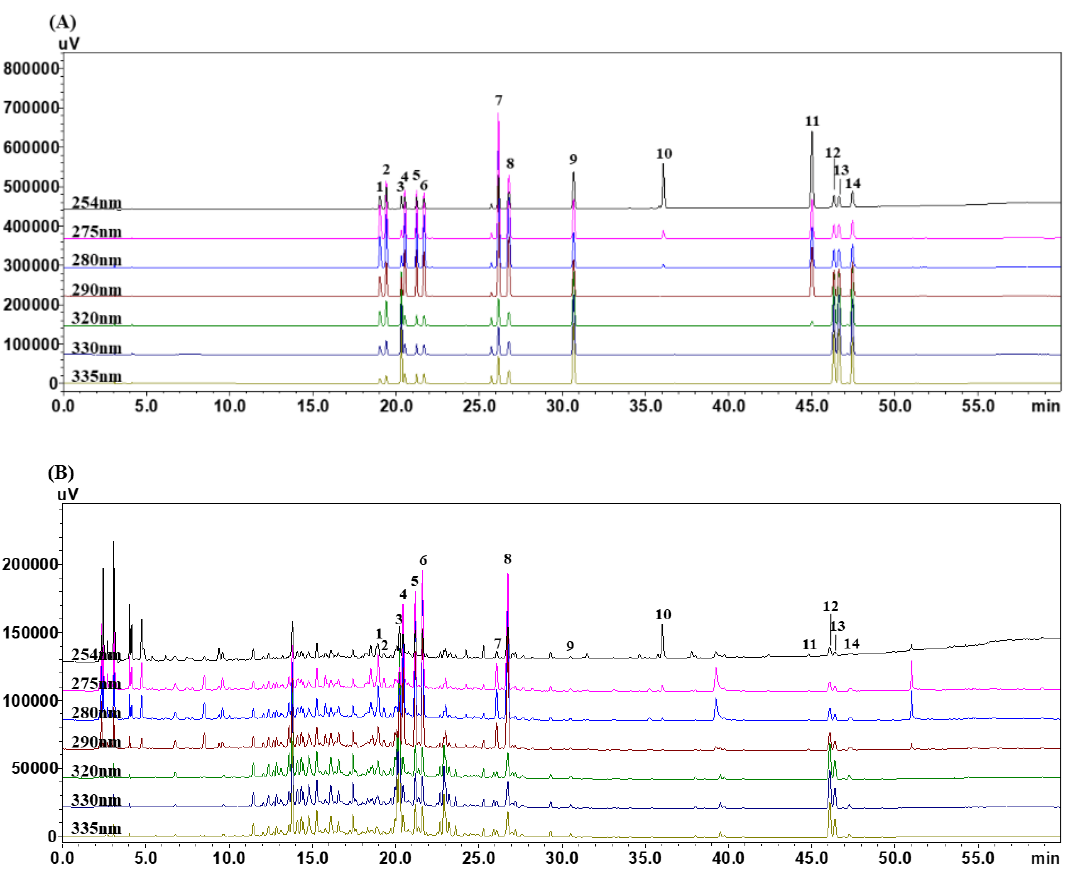
Figure 1. HPLC chromatograms of ( A ) standard solution and ( B ) Sojadodamgangki-tang (SDGT) sample. (1) liquiritin apioside (LIQA), (2) liquiritin (LIQ), (3) nodakenin (NOD), (4) narirutin (NAR),